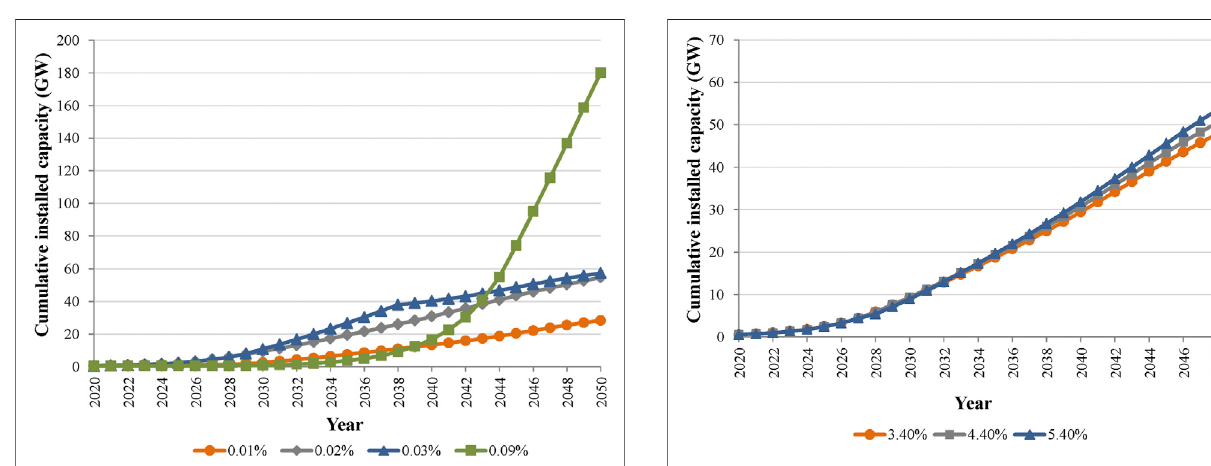
FIGURE 6 | Cumulative installed CSP capacity under different investment proportions.